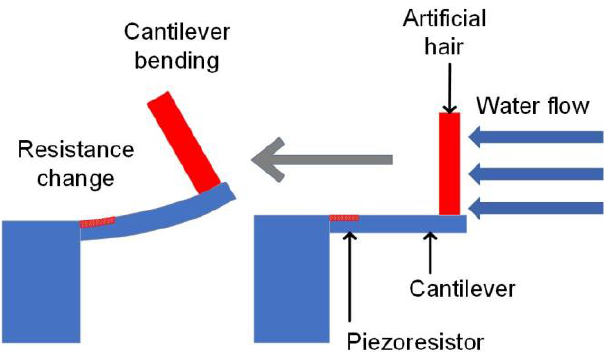
Figure 2. A schematic drawing illustrates the working principle of the AHC flow